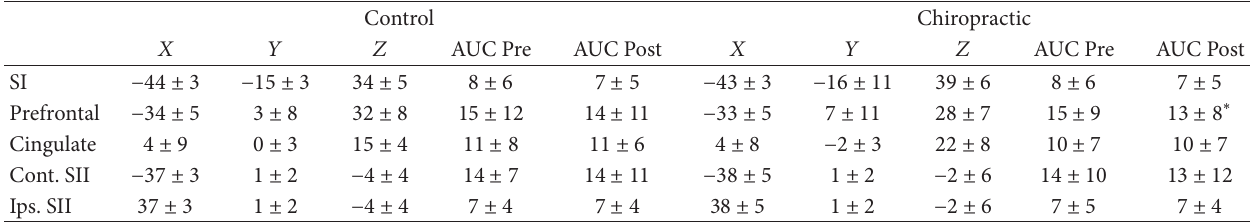
Table 1: Brain source coordinates and their areas under